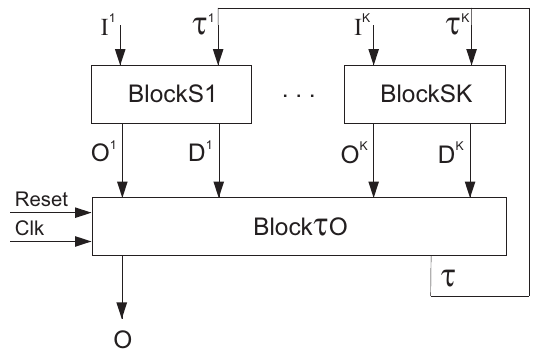
Figure 4. Structural diagram of P E Mealy